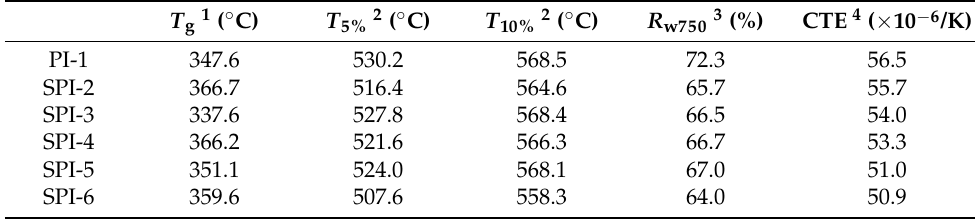
Table 3. Thermal properties of PI and SPIs.